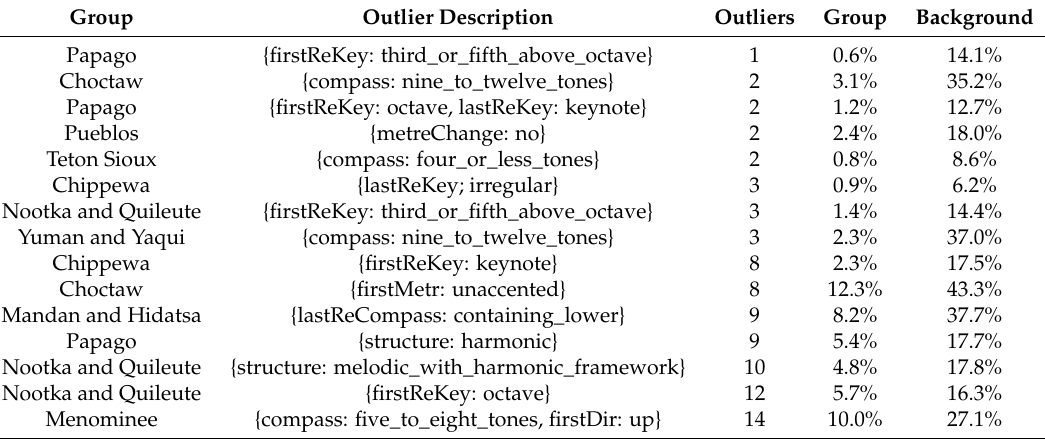
Table 3. Significantly infrequent minimal contrast patterns in the Densmore collection